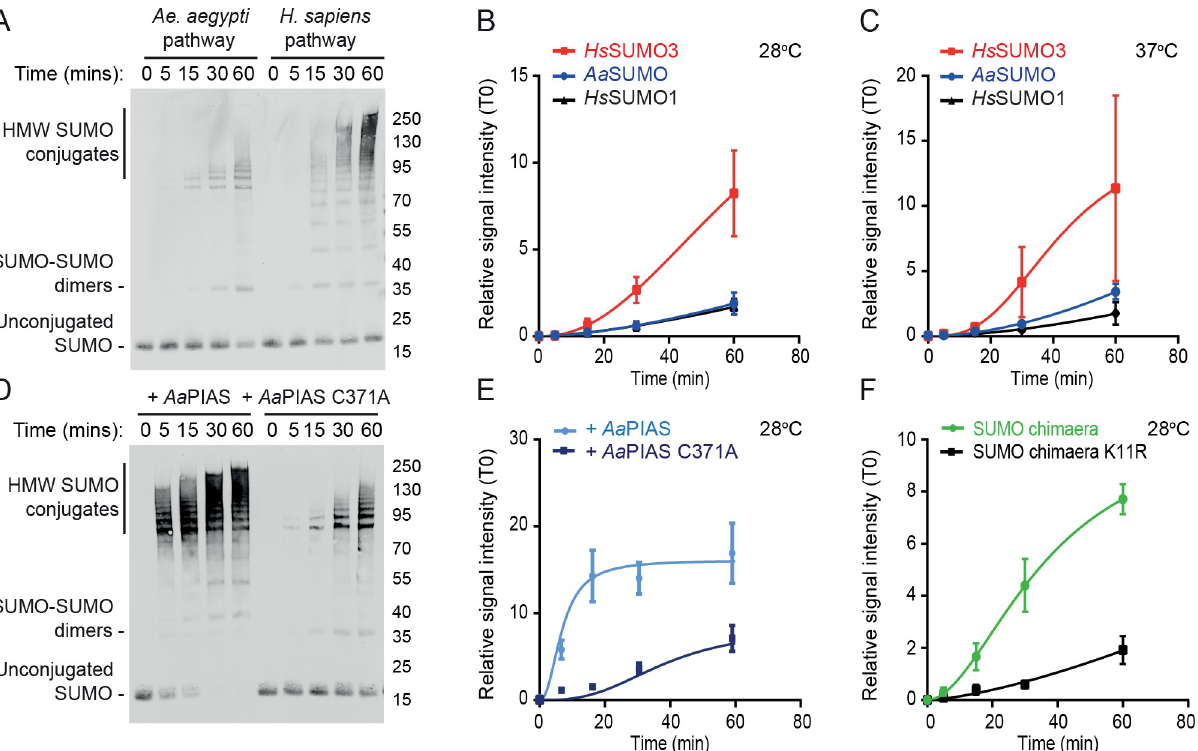
Fig 2. Aa PIAS is required for efficient poly- Aa SUMO chain formation. Purified Ae . aegypti and H . sapiens SUMO, Ubc9, and SAE1/2 recombinant proteins (50 ng each per reaction, S1 Fig) were incubated in the presence of 5 mM ATP for the indicated time points (minutes, min). (A) Representative western blot showing the accumulation of high molecular weight (HMW) SUMO conjugates over time at 28˚C. Free SUMO, SUMO-SUMO dimers, and HMW conjugates highlighted. Molecular mass markers shown. (B/C) Quantitation of the accumulation of HMW SUMO conjugates (as in A; � SUMO dimers) at 28 or 37˚C (B and C, respectively). N � 3 independent reactions per condition; values normalized to T = 0 min (T0); mean and standard error of mean plotted. (D/E) Ae . aegypti SUMOylation pathway enzymes were incubated in the presence of WT or catalytically inactive (C371A) Aa PIAS (10 ng) for the indicated time points at 28˚C. (D) Representative western blot showing the accumulation of HMW SUMO conjugates in the presence of WT Aa PIAS. (E) Quantitation of the accumulation of HMW SUMO conjugates (as in D and described in B). (F) Ae . aegypti SUMOylation pathway enzymes (SAE1/2 and Ubc9) were incubated in the presence of chimaeric SUMO (amino acids 1–14 of Hs SUMO3 [including WT or mutant (K11R) SCM] in frame with the C-terminus of Aa SUMO) for the indicate time points at 28˚C. Western blots were quantified for the accumulation of HMW SUMO conjugates (as described in